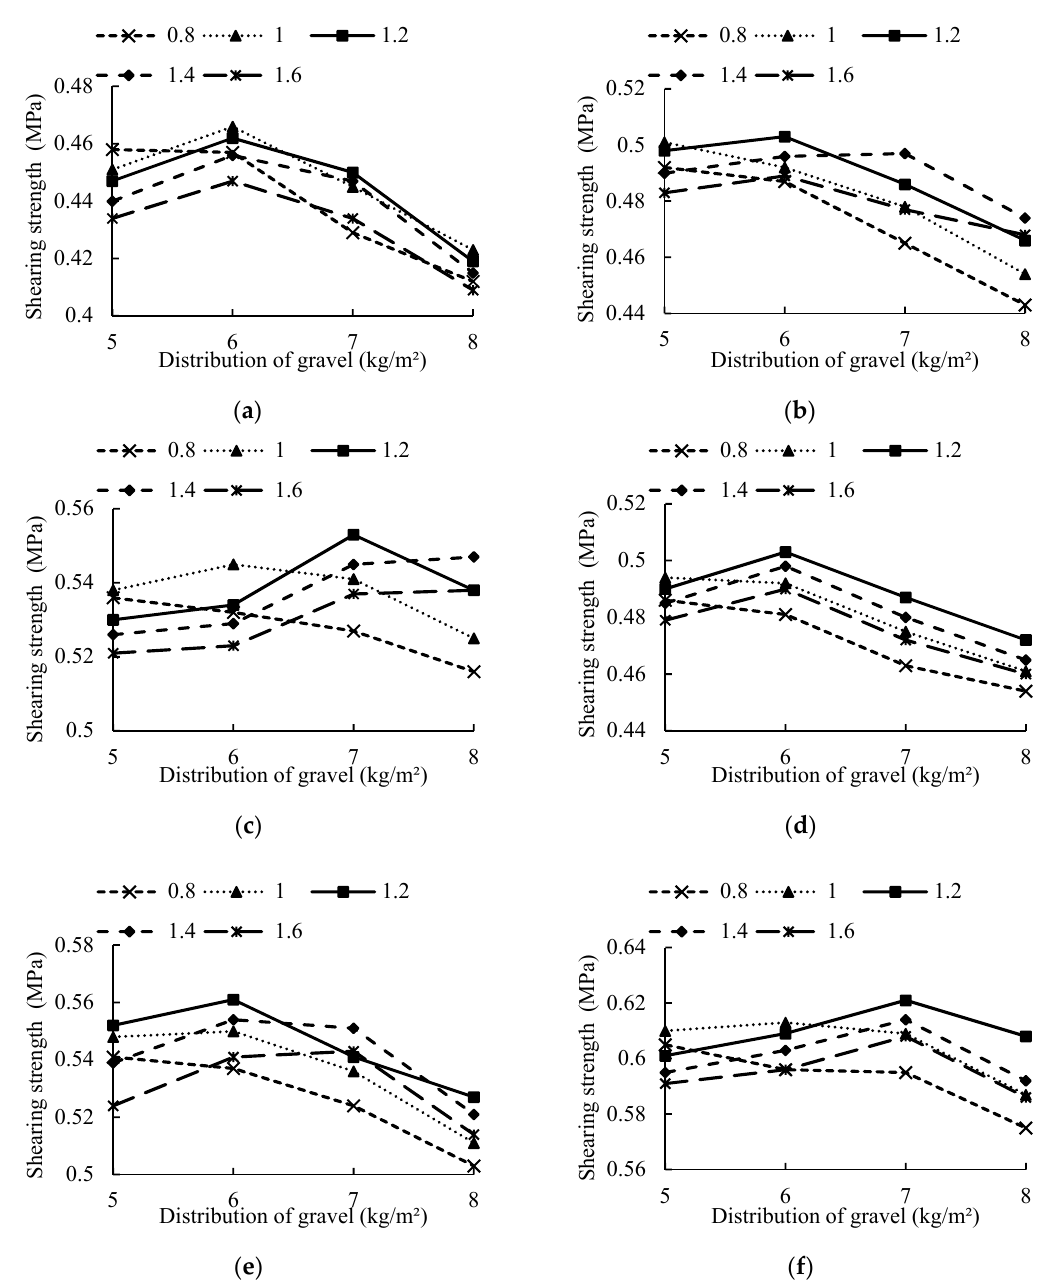
Figure 6. Shear strength of SBS-modified asphalt with different spreading and disposal schemes: ( a ) Mod-A-brushed; ( b ) Mod-A-grooved; ( c ) Mod-A-exposed; ( d ) Mod-B-brushed; ( e ) Mod-B-grooved; ( f ) Mod-B-exposed.